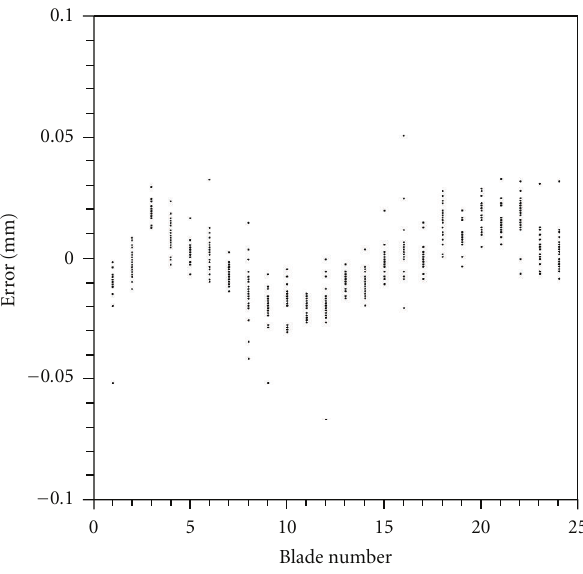
Figure 11: Error in FM capacitance probe measurements plotted against blade number around the spinning rig wheel, illustrating a +1 / − 0 . 025 mm variation in blade height due to shaft